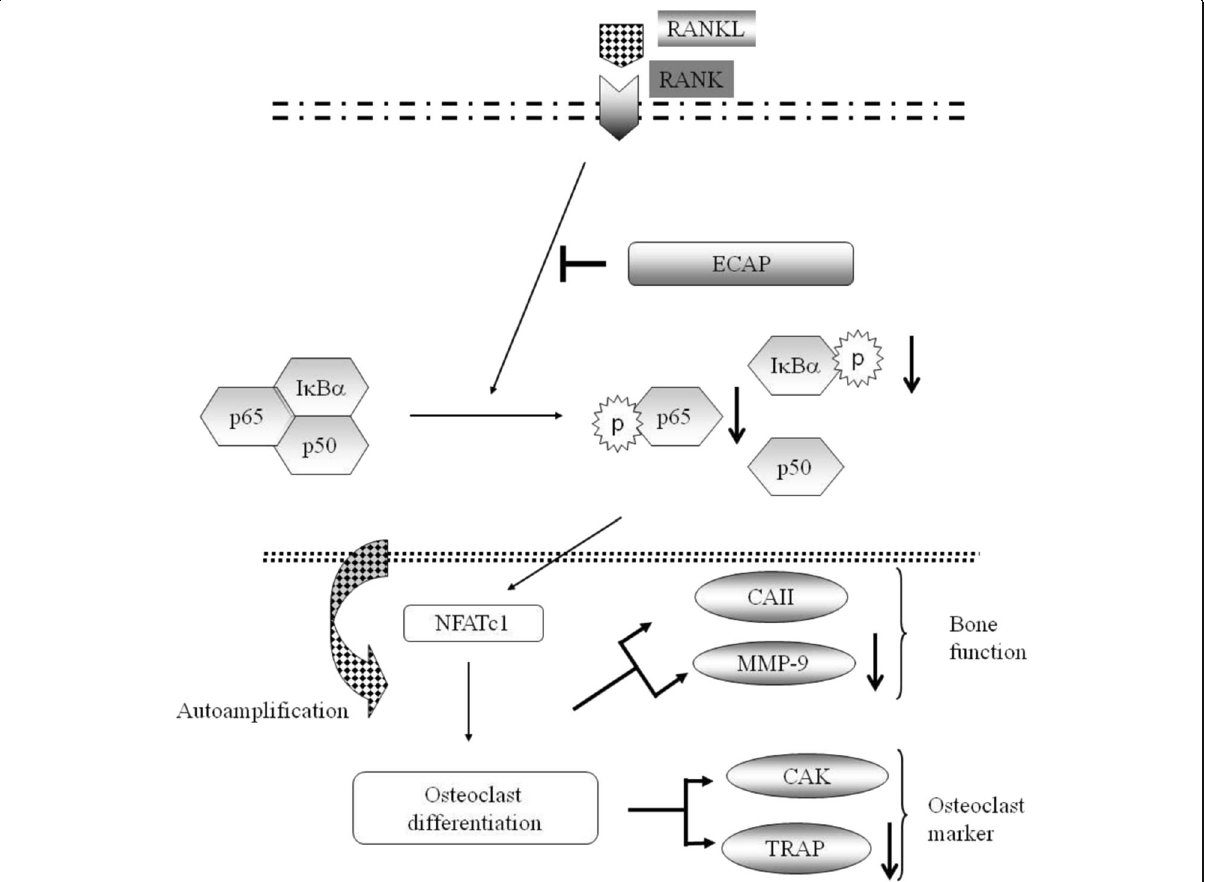
Fig. 7 Proposed intracellular actions of ECAP to suppress RANKL-induced osteoclastogenesis in RAW264.7 cells. ECAP, ( − )-Epicatechin 3-O- β - D -allo- pyranoside; CAII, carbonic anhydrase II; MMP-9, matrix metalloproteinase-9; CAK, cathepsin K; TRAP, tartrate-resistant acid phosphatase; NFATc1, nuclear factor of activated T cells c1; RANKL, receptor activator of nuclear factor kB (NF-kB)